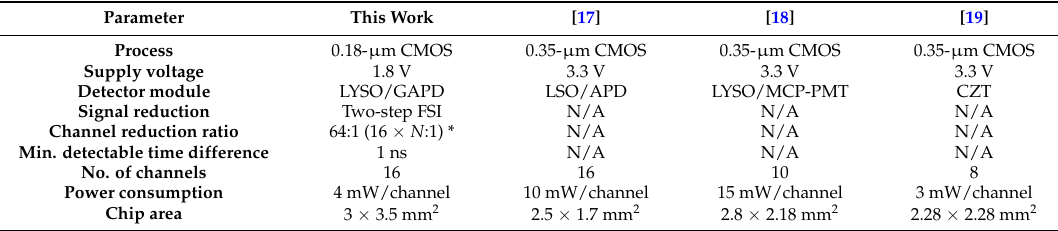
Table 1. Comparison with previously reported